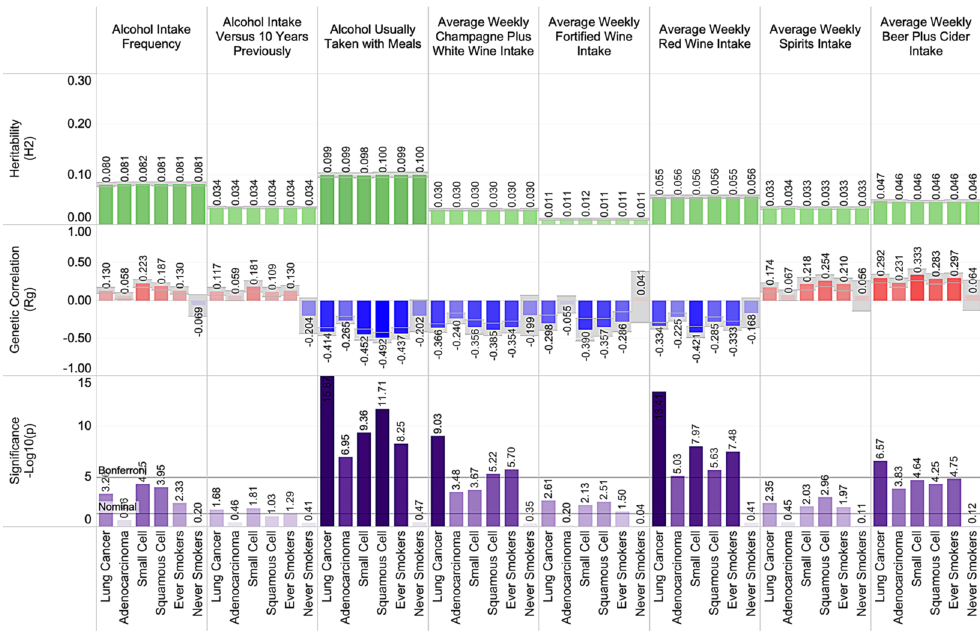
Figure 2. The shared heritability and genetic correlation between alcohol use and lung